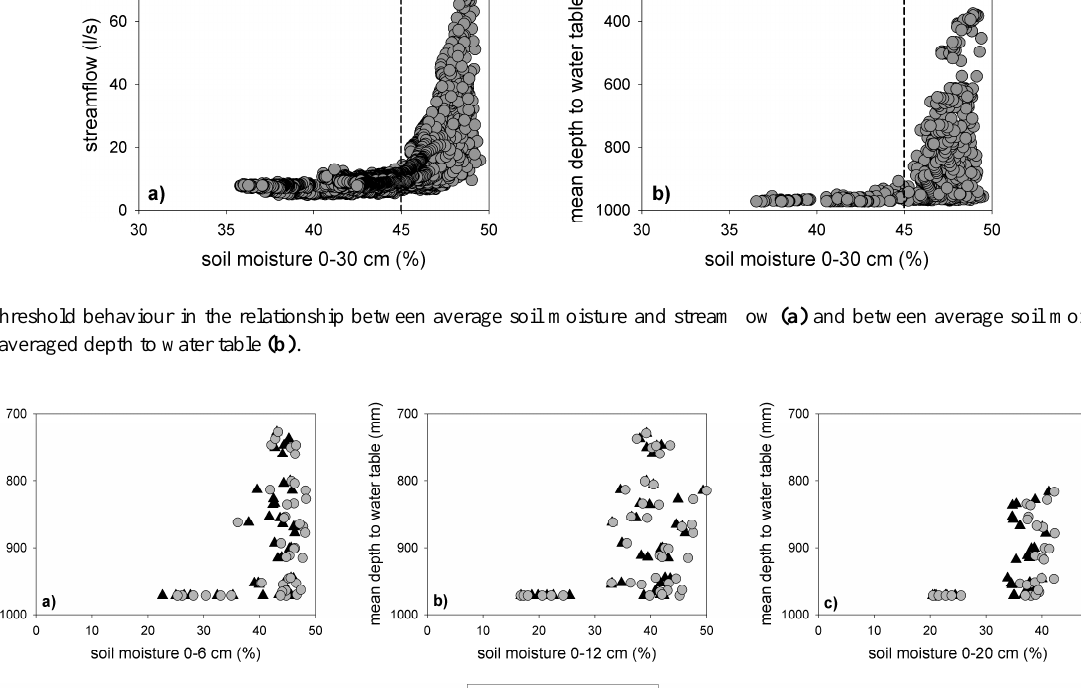
Figure 6. Threshold behaviour in the relationship between hillslope-averaged soil moisture at 0-6 cm (a), 0-12 cm (b), 0-20 cm (c) and hillslope-averaged depth to water table.